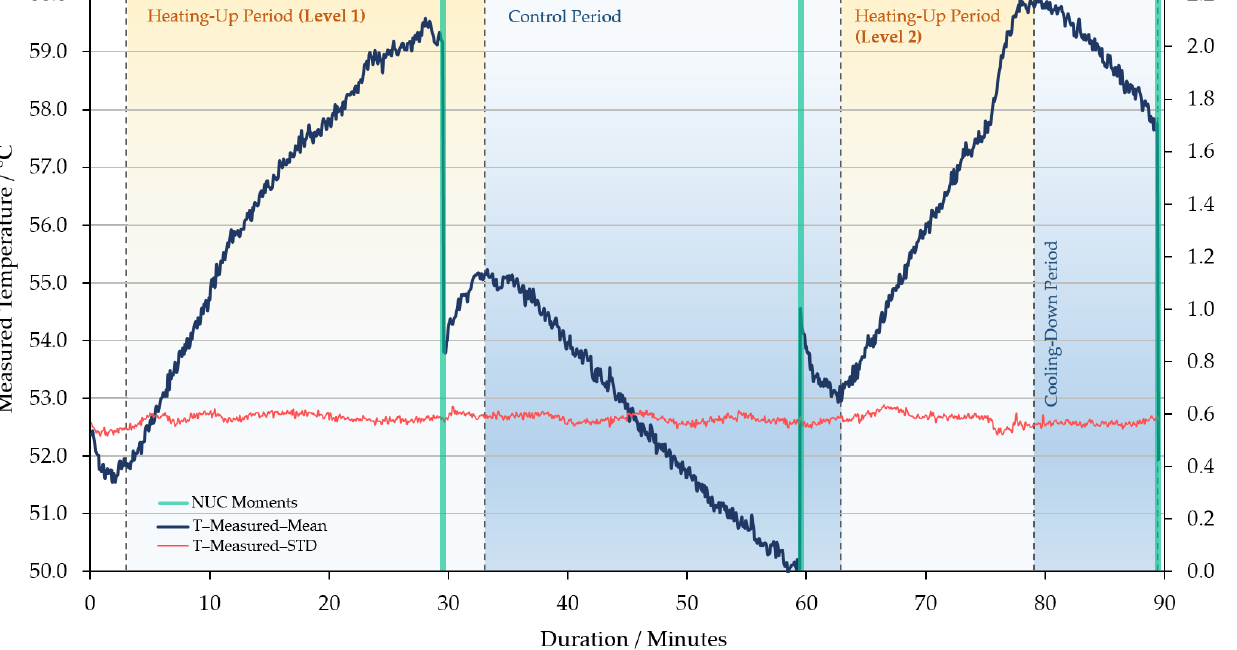
Figure 12. Simulation of the effect of (radiative) heating on WIRIS by a thermo-heater gun, while imaging a blackbody at 55 °C. A control period was set between wind tests. The STD of the measured temperature values is also included. The housing temperature is not available for this session.